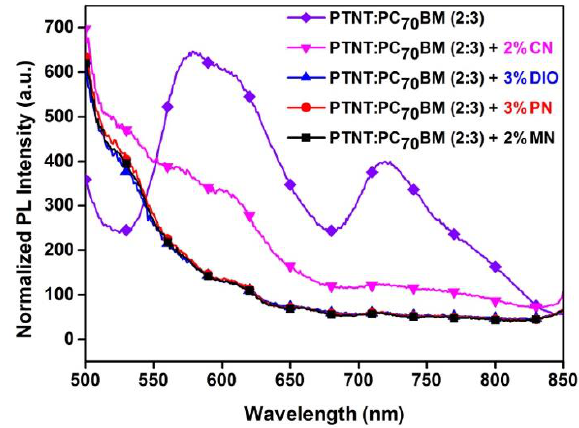
Figure 3. Normalized photoluminescence (PL) emission spectra of active layers from PTNT:PC 71 BM blends using different solvent additives (normalized to film thickness).